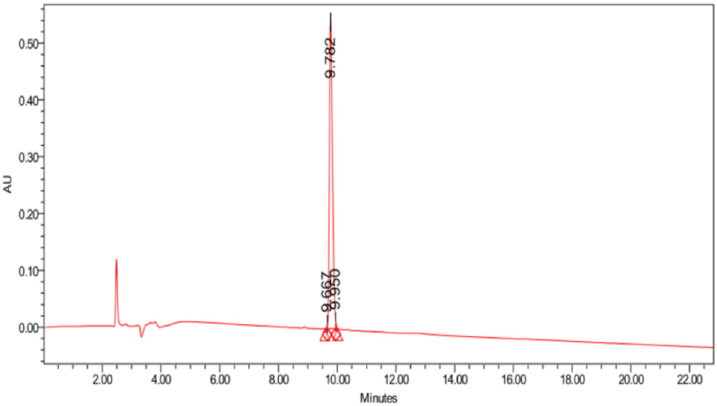
Figure 4. HPLC analysis of NH 2 -Cys(Bzl)-Pro-COOH.